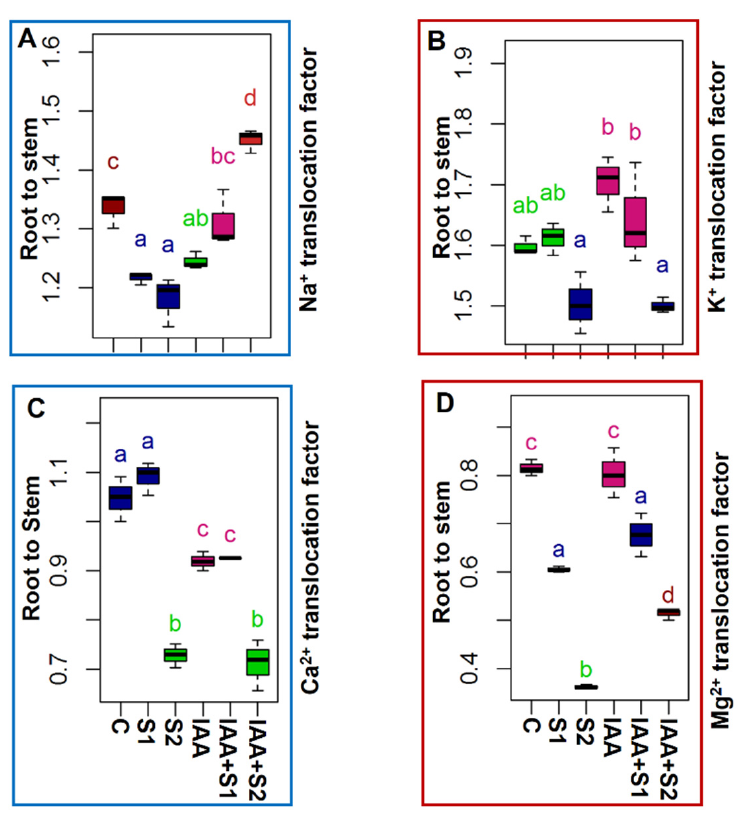
Figure 4. Effects of exogenous IAA on translocation factor of different minerals from root to stem of V. faba plants grown under non- stress and saline conditions. ( A ) Na + translocation factor: root to stem, ( B ) K + translocation factor: root to stem, ( C ) Ca 2+ translocation factor: root to stem, ( D ) Mg 2+ translocation factor: root to stem. Each boxplot represents values of three independent replicates ( n = 3). Different letters above the bars indicate a statistically significant difference ( p < 0.05) by Tukey’s test. C, (control) 0 mM NaCl + water spray; S1, 60 mM NaCl + water spray; S2, 150 mM NaCl + water spray; IAA, 0 mM NaCl + 200 ppm IAA; IAA + S1, 60 mM NaCl + 200 ppm IAA; IAA + S2, 150 mM NaCl + 200 ppm